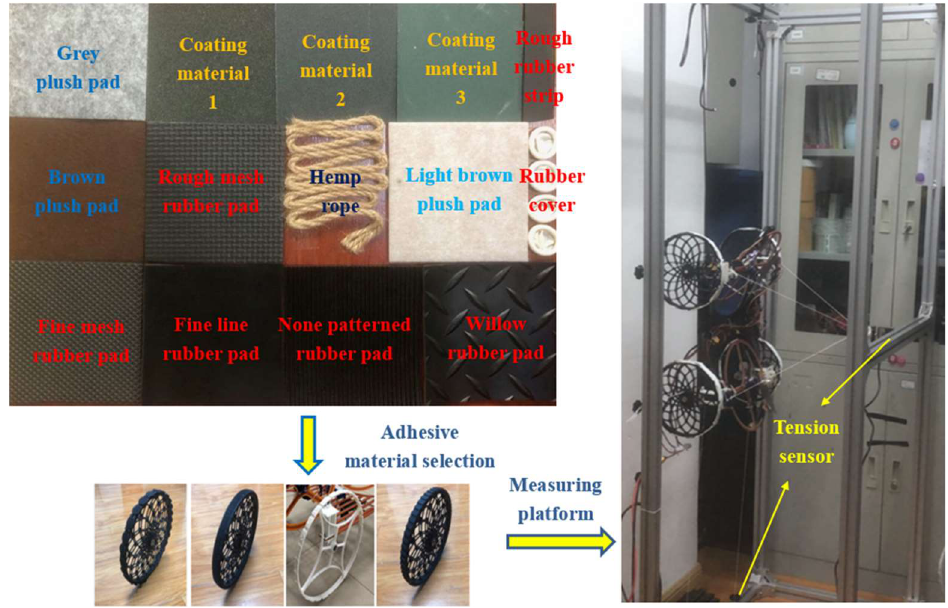
Figure 5. Selection of different adhesive materials for wheel surfaces. Table 1. Comparison of material properties of different adhesive materials for wheel surface.